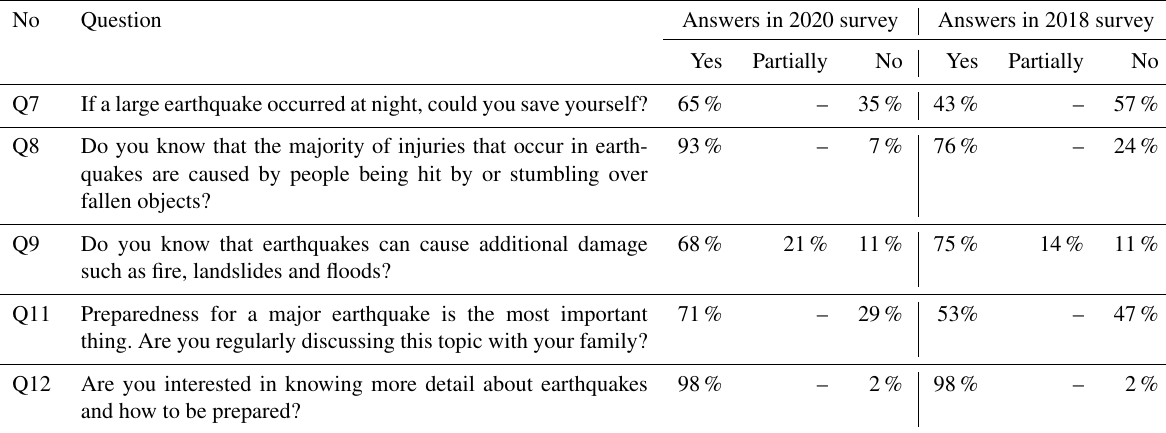
Table 1. Questions and respective answers about earthquake preparedness among students who participated in the surveys, before and after our education program was initiated in central Nepal. Respective statistical indicators are reported in Table S1 in the